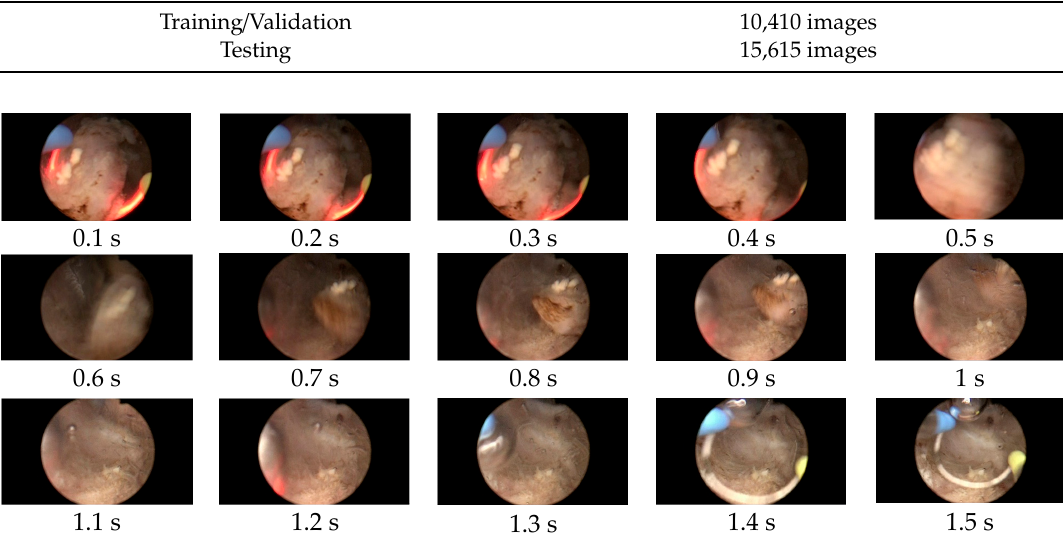
Table 3. The dataset ratio of the transurethral resection of the prostate (TURP) surgery. Training / Validation